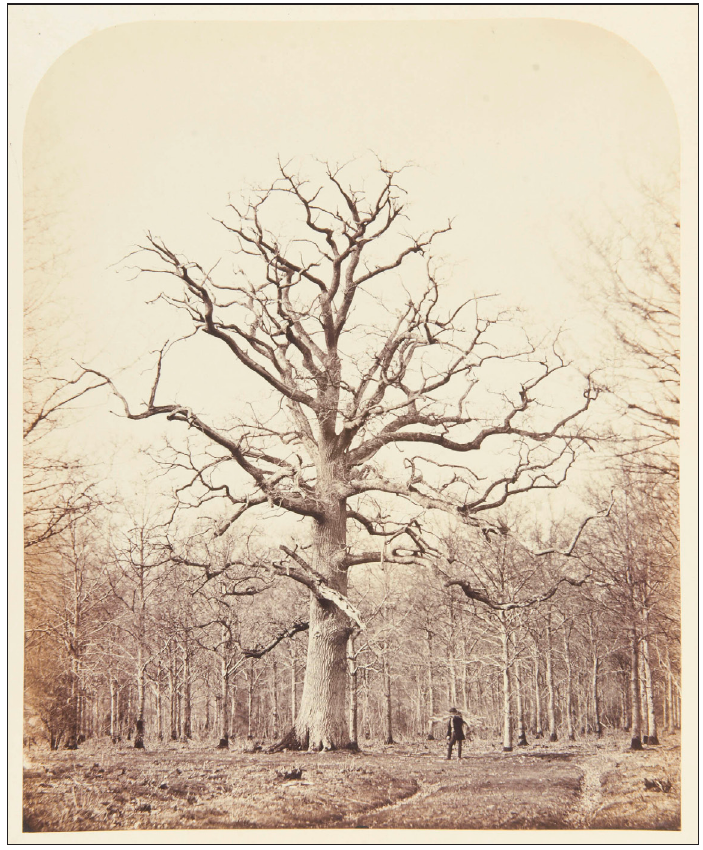
Fig . 10 : William Bambridge, Queen Anne’s Oak, Windsor Great Park , 1864, albumen print, 29 × 23.5 cm. Royal Collection Trust/© Her Majesty Queen Elizabeth II